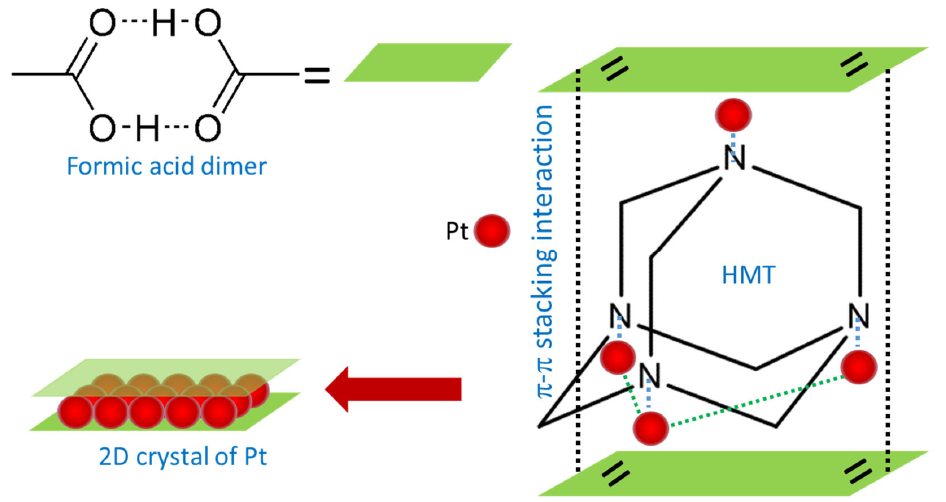
Figure 6. Mechanism of ultimate 2D crystal of Pt. Reduced Pt ion is predicted to coordinate with N at the corner of hexamethyletetramine (HMT) molecule. The formic acid dimer planes may then cover up the metal-attached HMT via π - π stacking interaction to form a 2D